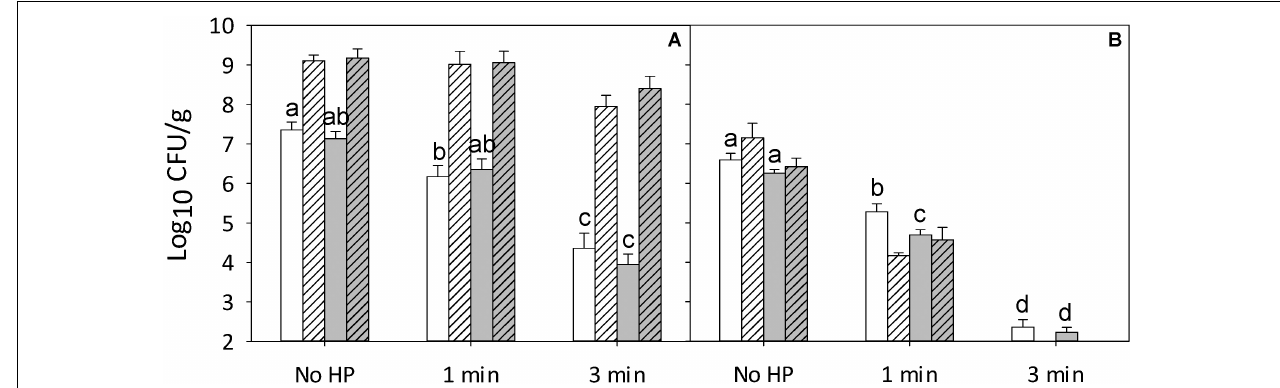
FIGURE 2 | Effect of pressure and RTE meat microbiota on survival and post-pressure growth of L. monocytogenes and RTE meat microbiota on ham treated with 0.5% ethanol (solvent control) or an equivalent volume of rosemary extract in 0.5% ethanol. Shown are total cell counts (A) on non-selective agar and cell counts of L. monocytogenes (B) enumerated on selective PALCAM (B) agar. Samples were treated at 500 MPa for 1 or 3 min without (white) or with (gray) rosemary at ∼ 325 µ g/cm 2 . Cell counts were enumerated immediately after pressure treatment (solid columns) and after storage for 4 weeks at 4 ◦ C (hatched columns). Data are shown as means ± standard deviations of triplicate independent experiments. Treatment means (solid columns) within each panel with different letters are significantly different ( P < 0.05). The interception point of abscissa and ordinate represents the highest detection